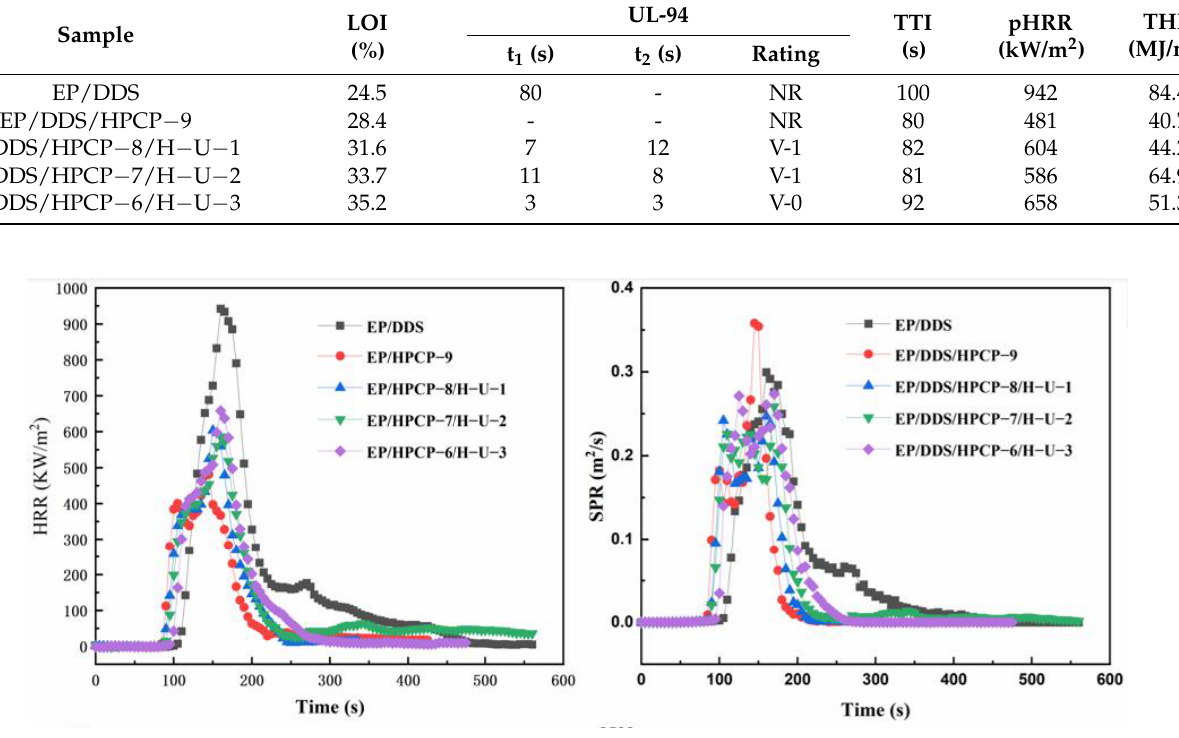
Figure 9. Plots of HRR ( a ), THR ( b ), SPR ( c ), and TSR ( d ) versus time of EP and its composites. Figure 10. Digital photos of char layers of EP/DDS ( a ), EP/DDS/HPCP − 9 ( b ), EP/DDS/HPCP − 8/H − U − 1 ( c ), EP/DDS/HPCP − 7/H − U − 2 ( d ), and EP/DDS/HPCP − 6/H − U − 3 ( e ) after cone tests. 3.5. FlameRetardant Mechanism TG-IR under N 2 conditions was conducted to detect the evolution of volatilized prod- ucts for EP samples during thermal degradation. The TG-IR spectra of gas products of EP thermosets are shown in Figures 11 and 12. As presented in Figures 11 and 12, both EP/DDS/HPCP − 9 and EP/DDS/HPCP − 6/H − U − 3 showed similar characteristic peaks at 3720 – 3860 cm −1 (-OH), 2020 – 2230 cm −1 (carbon monoxide), 1730 cm −1 (C-O), 1530 cm −1 (ben- zene), and 1160 cm −1 (aliphatic compounds). Figure 12a showed total absorbance of de- composition products of EP composites. Obviously, the total absorbance of decomposition products of EP/DDS reached a maximum while that of EP/DDS/HPCP − 9 was on the low- est level. Additionally, the absorbance of aliphatic compounds at 1160 cm −1 and hydrocar- bons at 2970 cm −1 of EP/DDS/HPCP − 6/H − U − 3 were higher than that of EP/DDS/HPCP − 9. This phenomenon indicates that the introduction of H − U leads to a worse carbon promo- tion effect, which matches the previous test results. The morphology and chemical composition of the char residues after cone calorime- ter tests were analyzed to study the flame retardant effect in condensed phase by SEM. As presented in Figure 13a, the char residue of pure EP/DDS was loose, with lots of pore spaces, indicating that pure EP thermosets cannot form continuous and stable char during